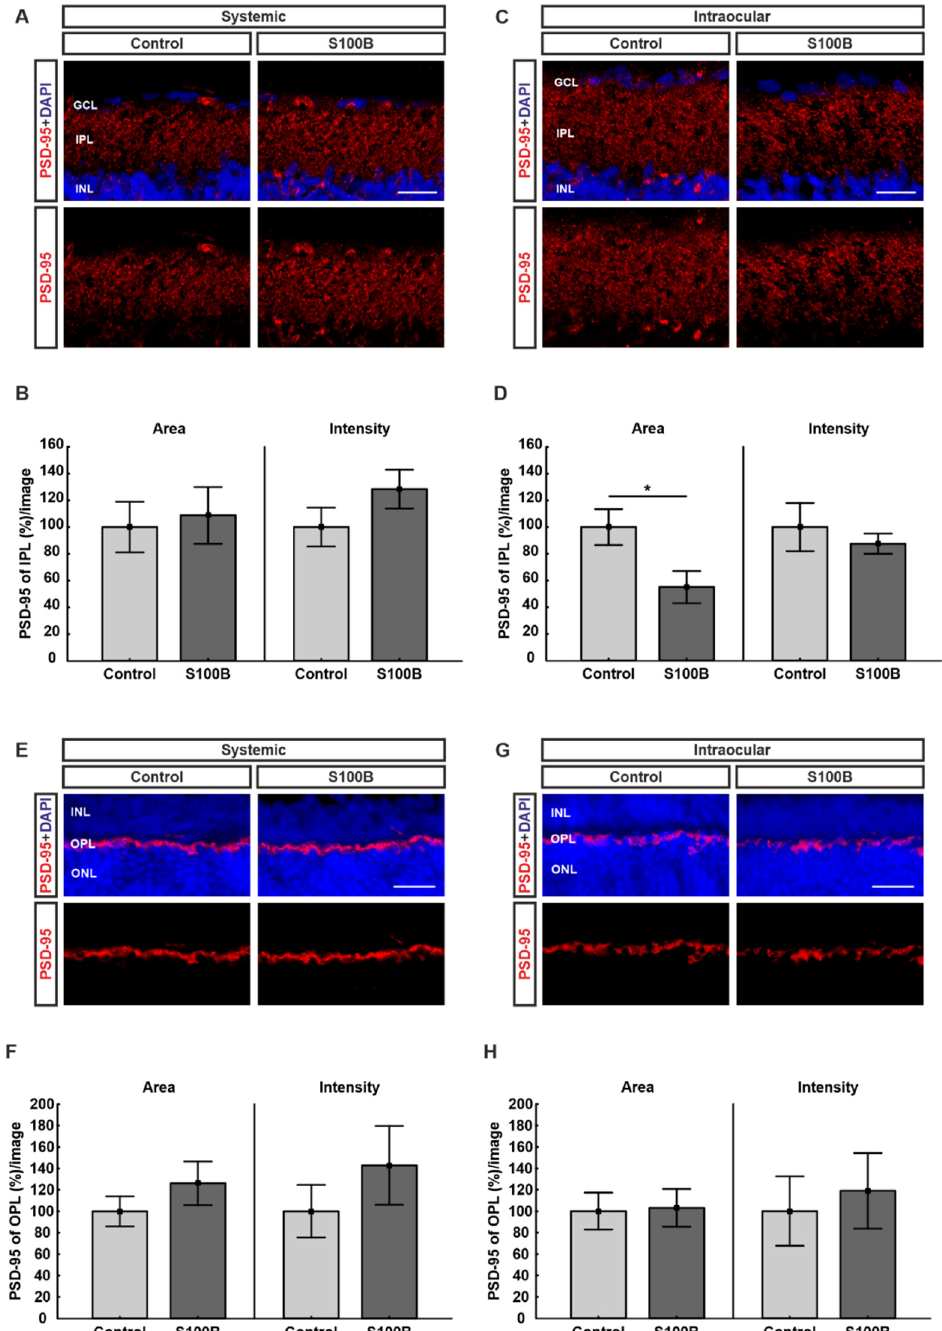
Figure 3. PSD-95 decreased in intraocular-injected animals. ( A ) Retinas from animals with systemic immunization were labeled against PSD-95 (red) in the IPL ( n = 7 / group). DAPI stained the cell nuclei (blue). ( B ) No di ff erences were noted regarding the stained area ( p = 0.76) as well as the intensity ( p = 0.19) of the staining in the IPL between both groups. ( C ) Retinas from intraocular-injected animals were stained with PSD-95 (red) in the IPL ( n = 6 / group). Cell nuclei were visualized by DAPI (blue). ( D ) Animals with intraocular S100B injection showed a diminished PSD-95 labeled area ( p = 0.03) in the IPL in comparison to controls. Regarding the percentage of intensity of the staining, no alterations were observed between both groups ( p = 0.53). ( E ) Retinas from systemically immunized animals ( n = 7 / group) were stained with PSD-95 (red) in the OPL. Cell nuclei were labeled with DAPI (blue). ( F ) Statistical examinations showed no di ff erences between both groups with systemic immunization regarding the PSD-95-stained area ( p = 0.31) and the intensity ( p = 0.35) of the staining in the